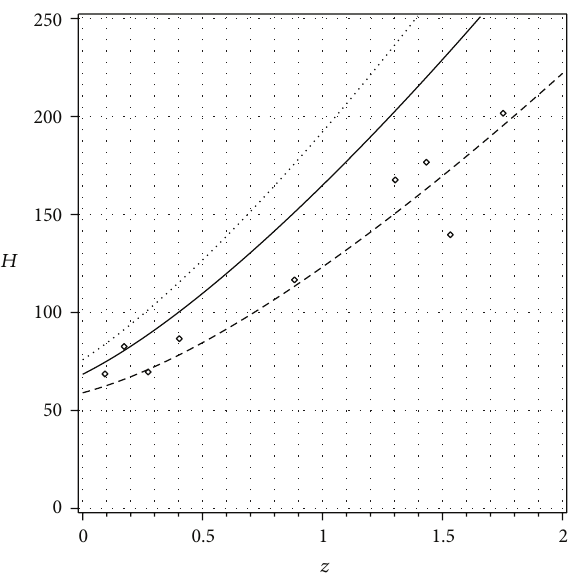
Figure 3: Hubble expansion parameter versus redshift for 𝐵 = 1 , 𝐴 = 1/3 , and 𝛼 = 0.9 for 𝐶 = 0.4 (dashed line), 𝐶 = 1 (solid line), and 𝐶 = 1.6 (dotted line), dots denote observational data [33].